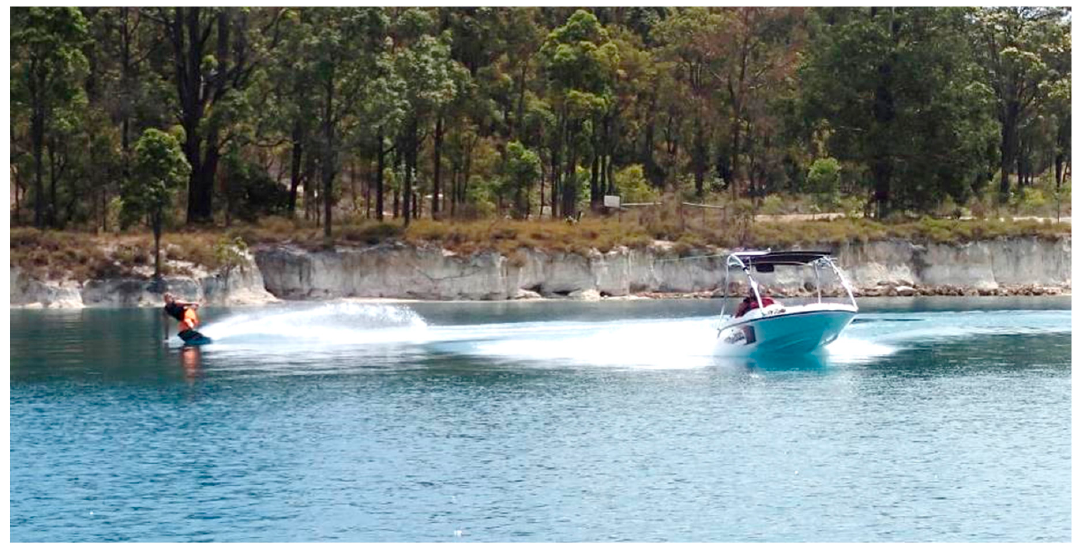
Figure 5. Water skiing on abandoned mine pit lake, Lake Stockton, in Western Australia.